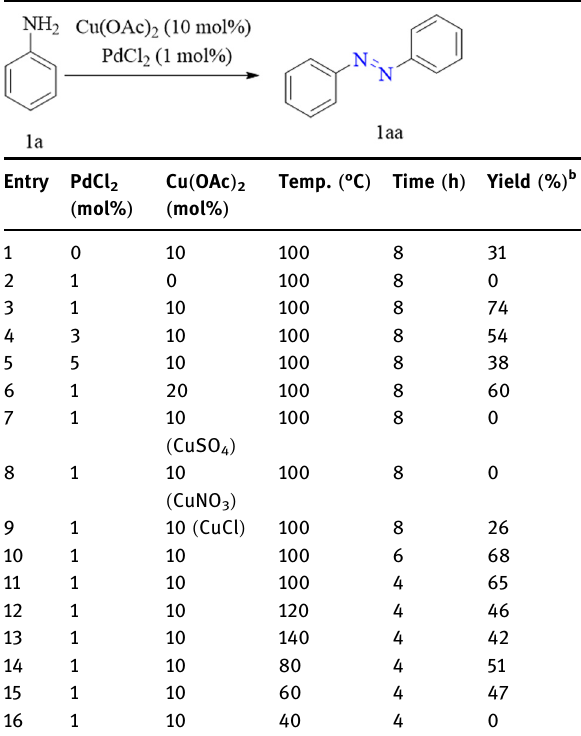
Table 2: Screening of various reaction parameters a